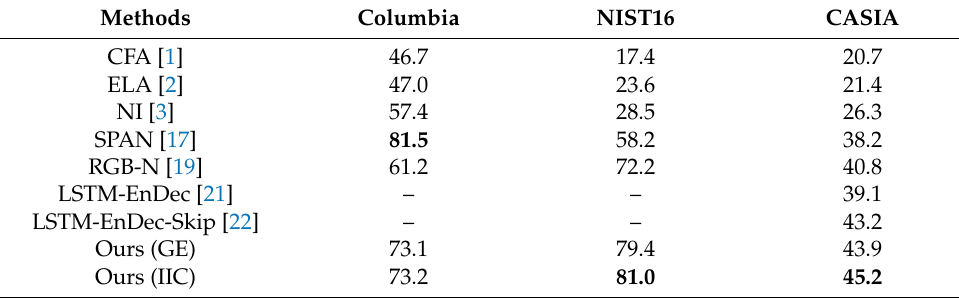
Table 3. F 1 score comparison on NIST16 and CASIA datasets